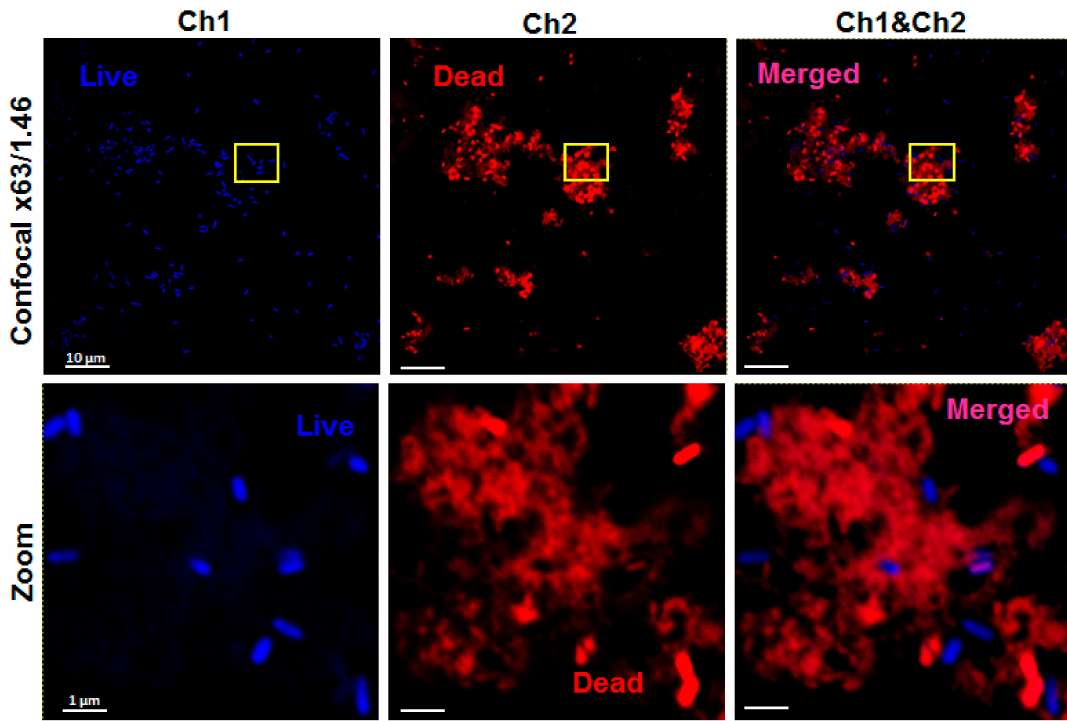
Figure 19. Laser scanning confocal microscopy images of the non-treated (upper panels), PDI-treated (middle), and PDI + KI-treated (bottom panels) E. coli stained with Hoechst3342 and PI. The yellows squares on the top panels indicate the zoom area displayed